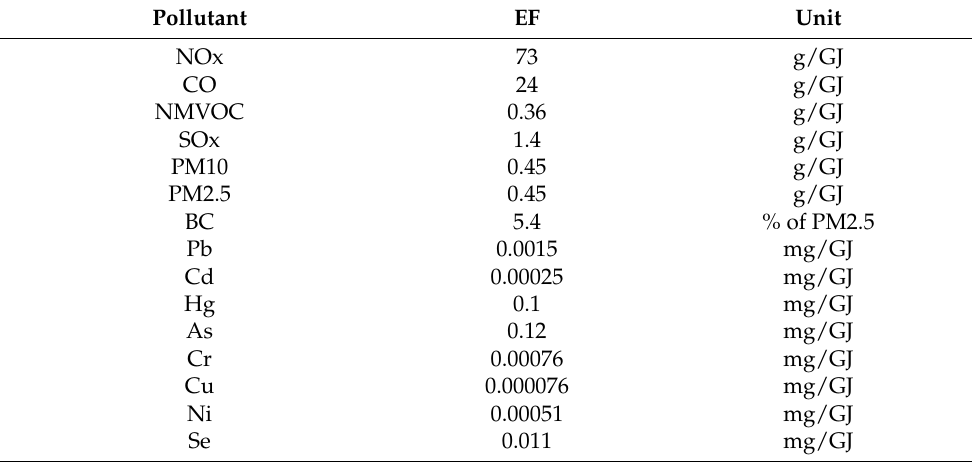
Table A1. Emission factors for medium-sized (>50 KWth to ≤ 1 MWth) boilers burning natural gas (source: EMEP/EEA emission inventory guidebook). KWth and MWth stands for Kilowatt Thermal and Megawatt Thermal, respectively